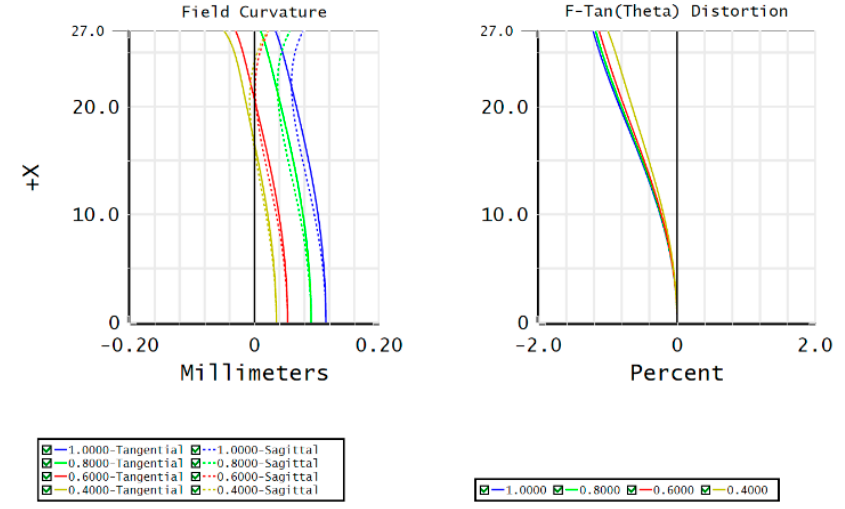
Figure 6. Modulation transfer function (MTF) of the front objective lens for ( a ) 400 nm, ( b ) 600 nm, ( c ) 800 nm, and ( d ) 1000 nm.